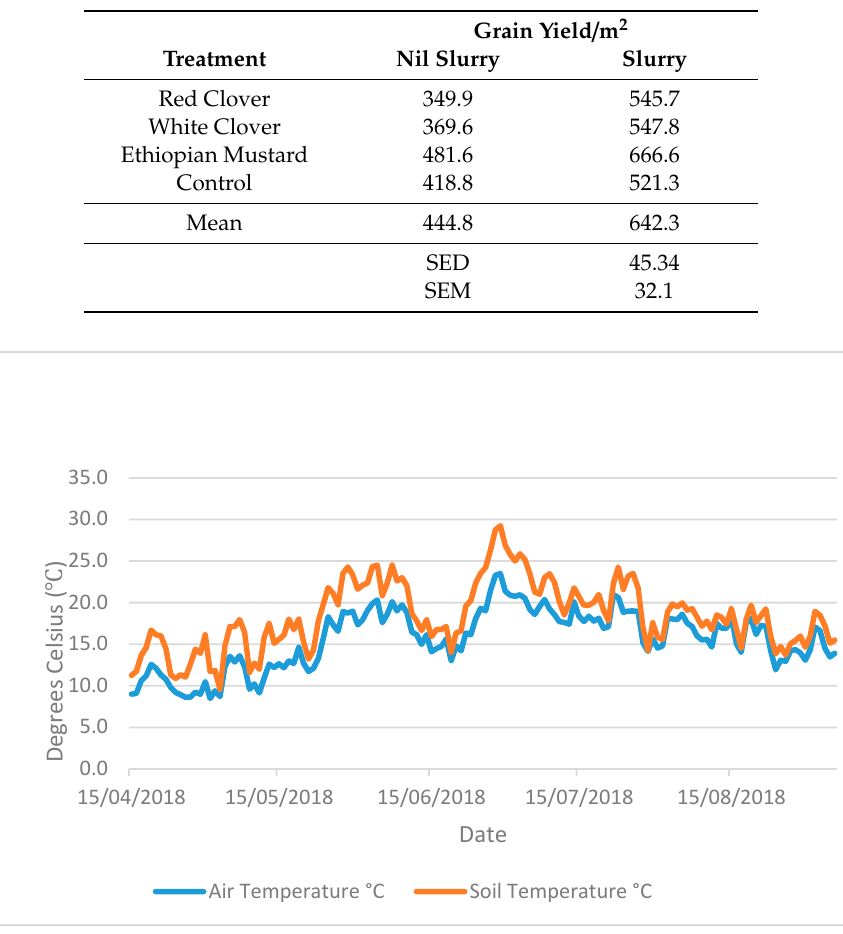
Figure A1. Average daily air and soil temperatures (°C).